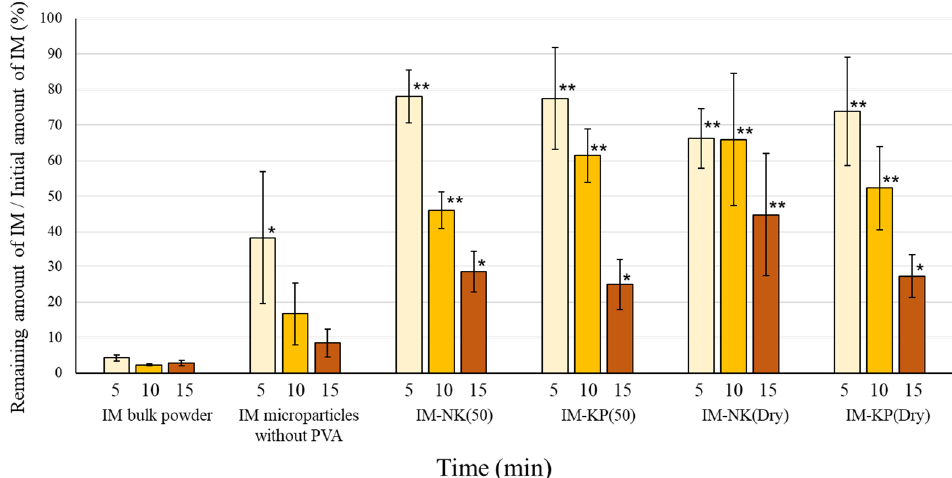
Figure 7. Drug Retention Ratio After the Application of IM Microparticles to Mucin Disks. Each Value Represents the Mean ± SD ( n = 3). ** p < 0.01, * p < 0.05; Dunnett’s Test Was Performed. IM Microparticles > IM Bulk Powder.